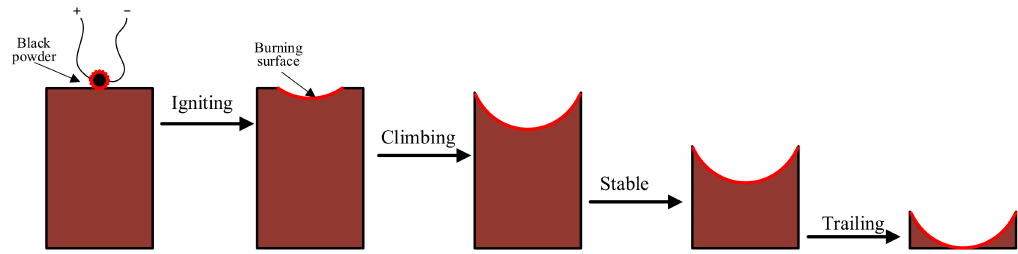
Figure 8. Schematic diagram of the propellant burning surface retreat during the test.